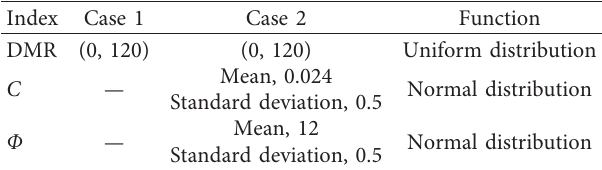
Table 5: Data input for the MCS.